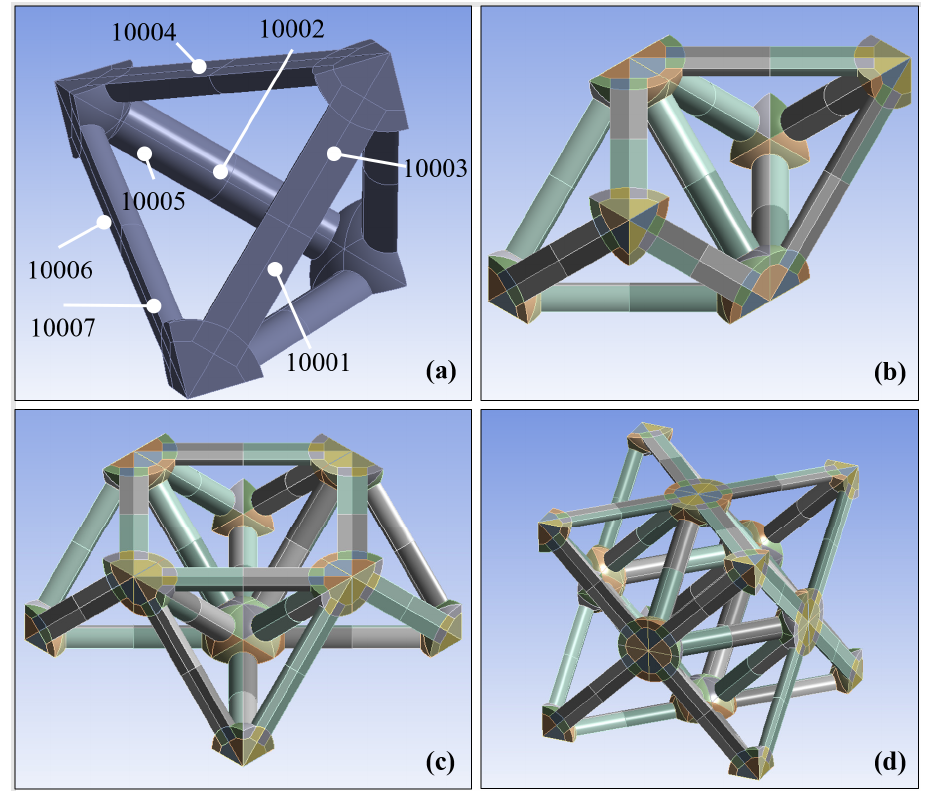
Figure 8. CAD Modeling an octet truss unit cell for numerical simulation; ( a ) six trusses that form a tetrahedron; ( b ) tetrahedron mirrored about the y-axis; ( c ) double tetrahedron from (b) mirrored about the x-axis; ( d ) half-call from (c) mirrored about the z-axis to form the octet truss unit cell.